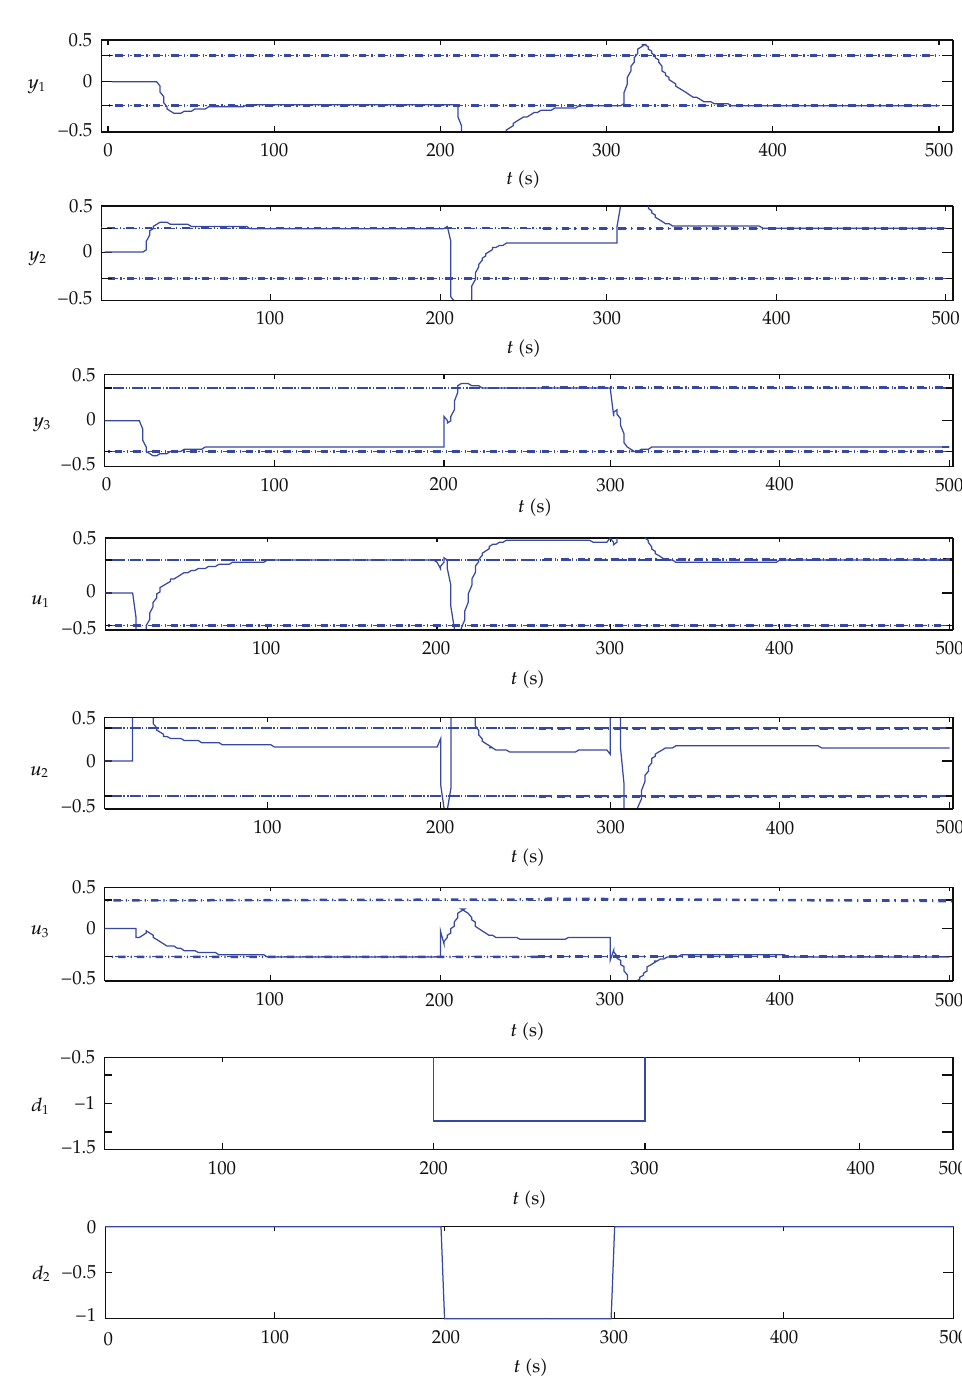
Figure 1: The closed-loop output trajectories, the corresponding control input signals, and the disturb-